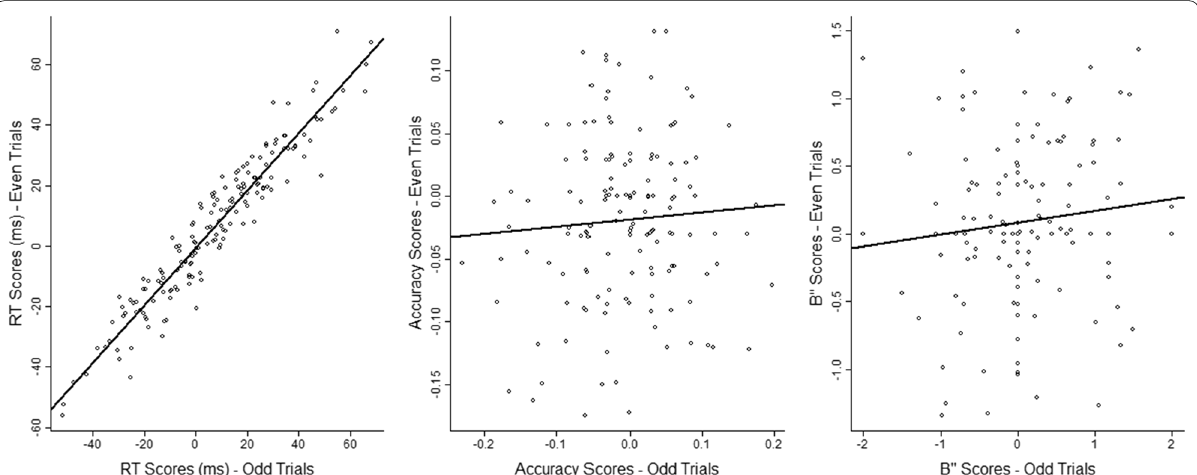
Fig. 8 Correlations between odd and even trials for three measures of the gun embodiment effect: reaction time (RT), accuracy, and B ″ . In each panel, each symbol corresponds to the data from one individual. Each score was calculated as a difference of difference scores, so positive values indicate the gun embodiment effect